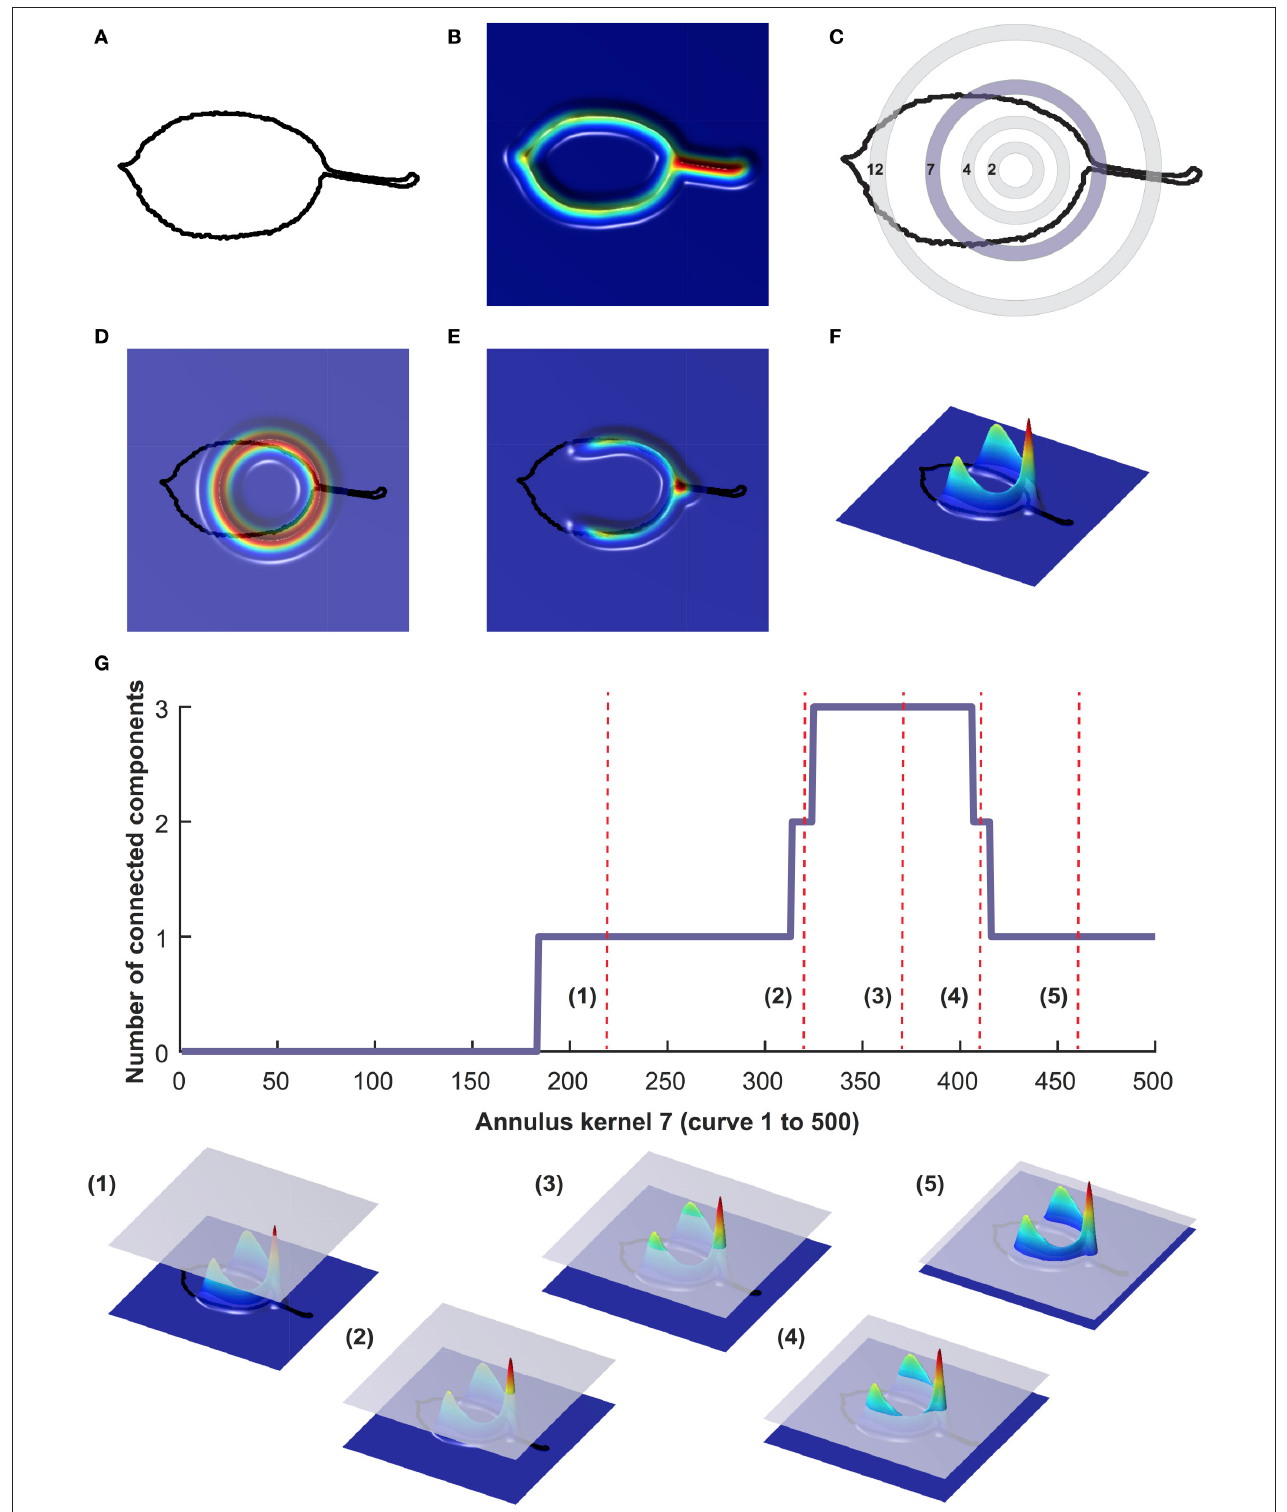
FIGURE 1 | Visualization of persistent homology technique for annulus kernel 7. Binary images were converted into a 2D point cloud (A) which was then normalized using a Gaussian density estimator (B) . For each leaf, 16 annulus kernels were used. Annulus kernel 7, indicated in purple (C) is used as an example for this visualization. The density estimator is multiplied by ring 7 (D) . The function can also be visualized from the side view (E,F) . As a plane moves from top to bottom, the number of connected components is recorded along the curve (G) . Below (G) are five visualizations of curves that are represented as red vertical dotted lines in (G) .